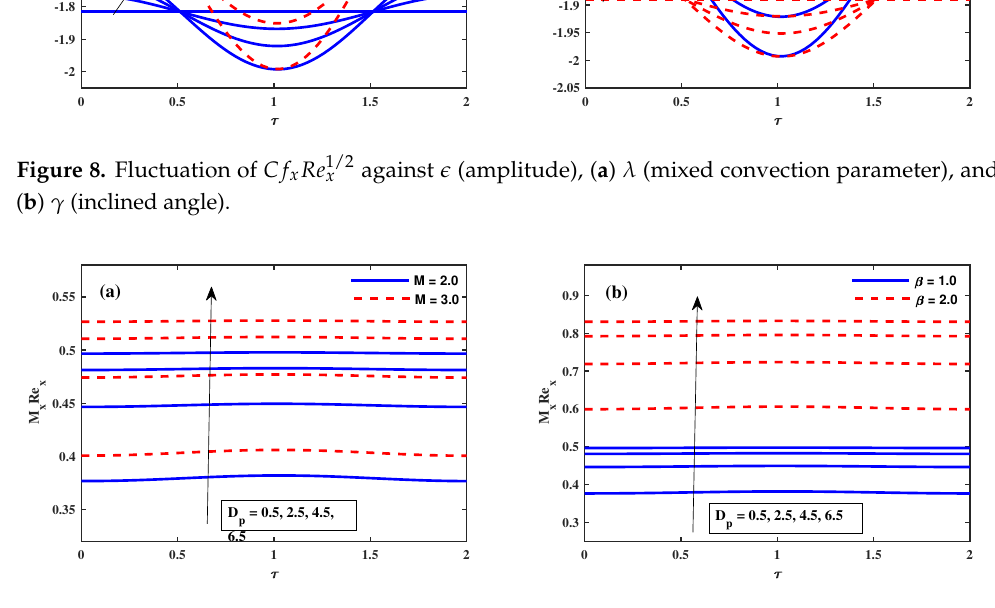
Figure 9. Fluctuation of M x Re x (couple stress) against D p (nanoparticle radius), ( a ) M (magnetic field), and ( b ) β (material